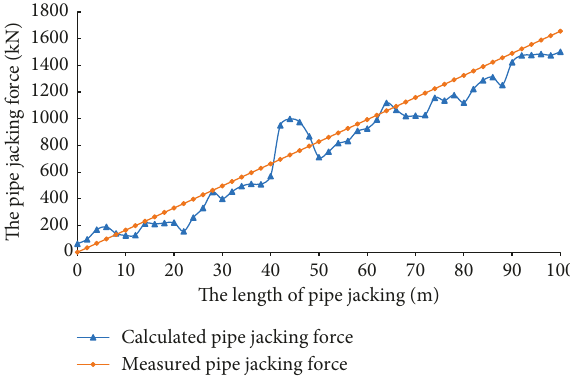
Figure 10: The calculated and measured pipe jacking